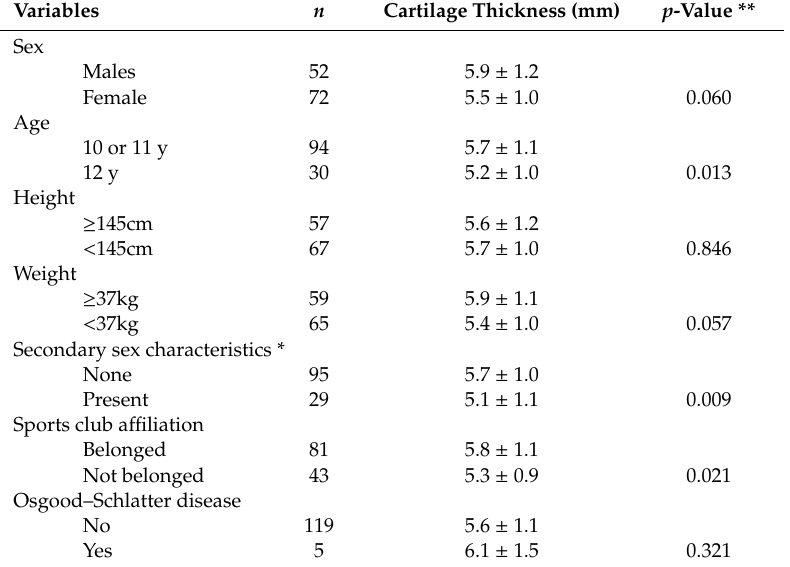
Table 3. Impact of demographic factors and Osgood–Schlatter disease on cartilage thickness in 124 grade 5–6 elementary